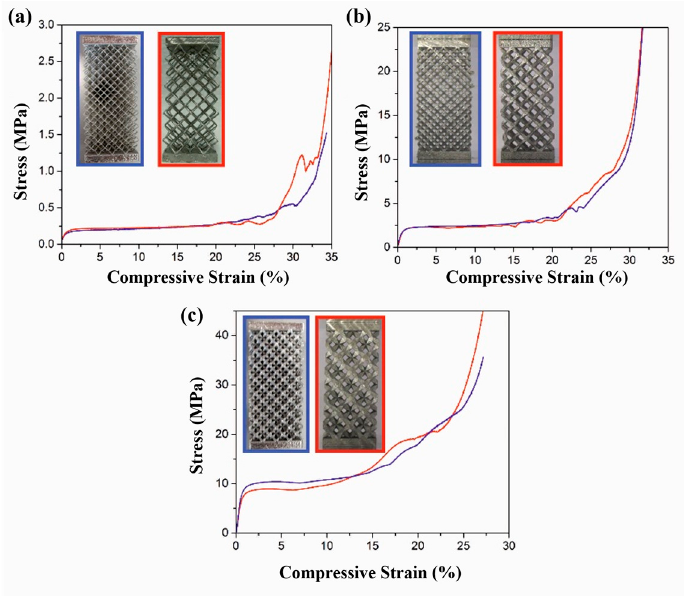
Figure 12. Compression stress-strain curves for the 2 × 2 × 4 (red curves) and the 4 × 4 × 8 rhombi-dodecahedron sandwich-structure (blue curves) at relative densities: ( a ) 4%; ( b ) 12%, and ( c ) 24%, respectively.